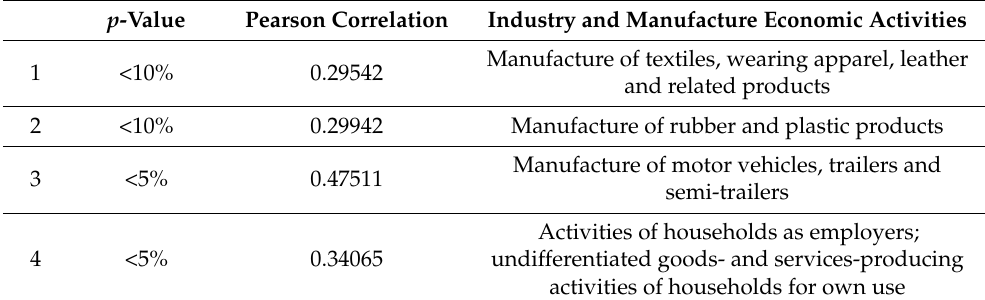
Table 3. Pearson correlation between changes in production in the main industries and manufacture activities and changes in urban air